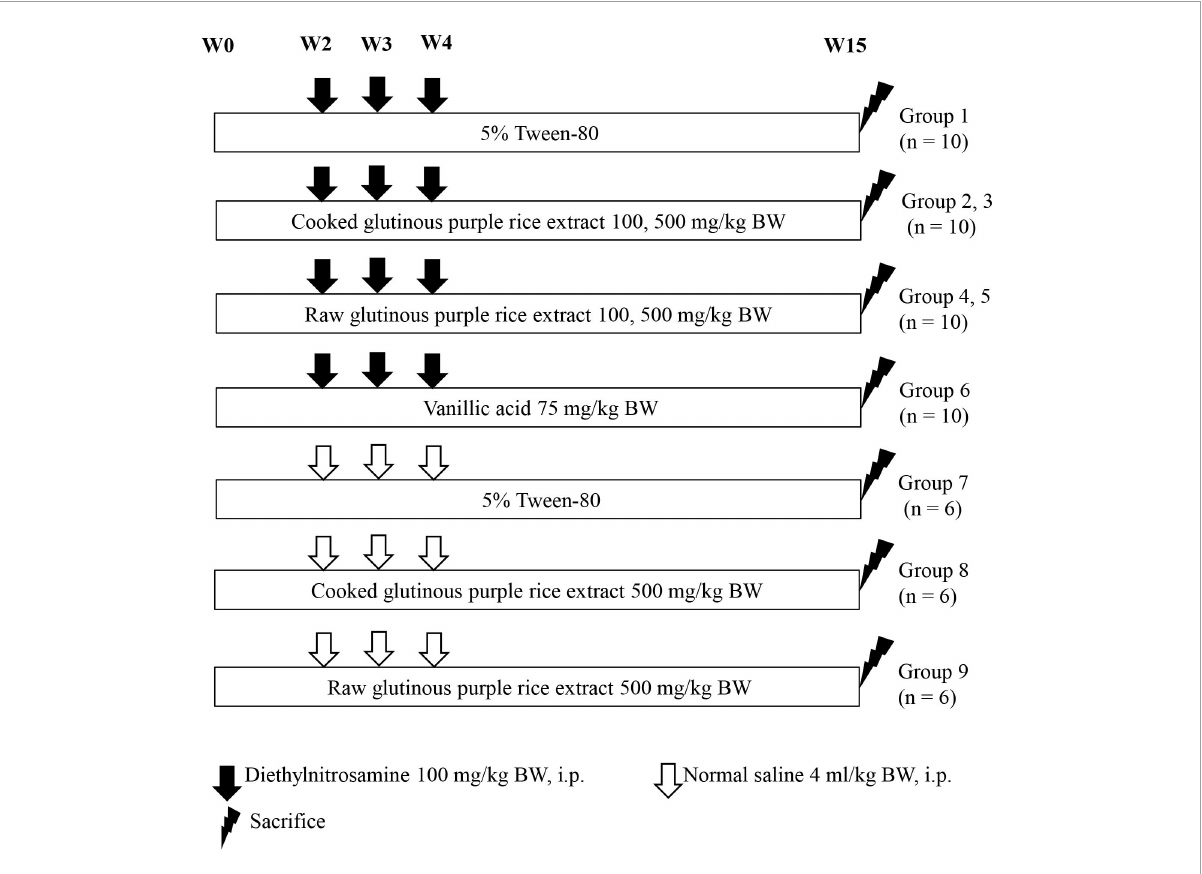
FIGURE1 Experimental protocol employed to study the effects of cooked glutinous purple rice extracts on the early stages of rat hepatocarcinogenesis.